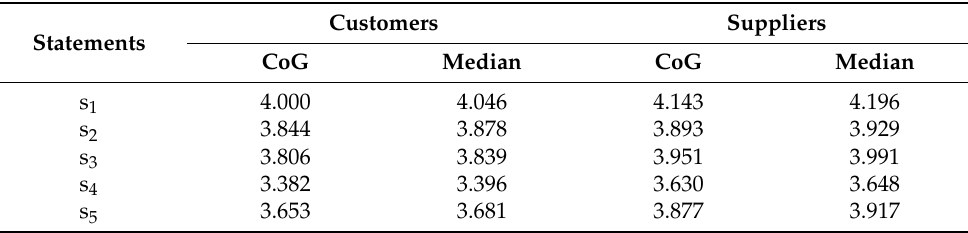
Table 5. Average ratings of the statements presented by the enterprise representatives after defuzzifi- cation the triangular fuzzy numbers (a group of customers vs. a group of suppliers).